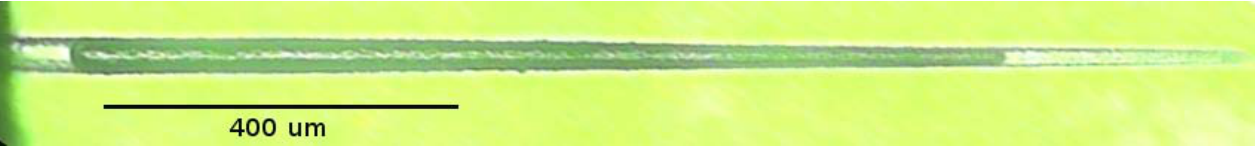
Figure 7. Photo of microchannel obtained applying 20 steps of dynamic displacement method Length ≈ 1.4 mm; aspect ratio ≈ 29. The parameters used for the etching are: PR = 50 mBar, PN = 500 mBar, τ R = 15 s, τ N = 165 s The black bubble inside the channel is air while the white part is filled with